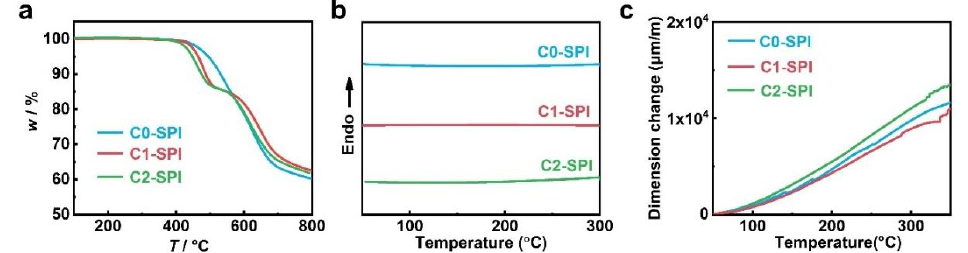
Figure 2. ( a ) TGA curves, ( b ) DSC curves, and ( c ) TMA curves of the three polyimides C0-SPI, C1-SPI, and C2-SPI.